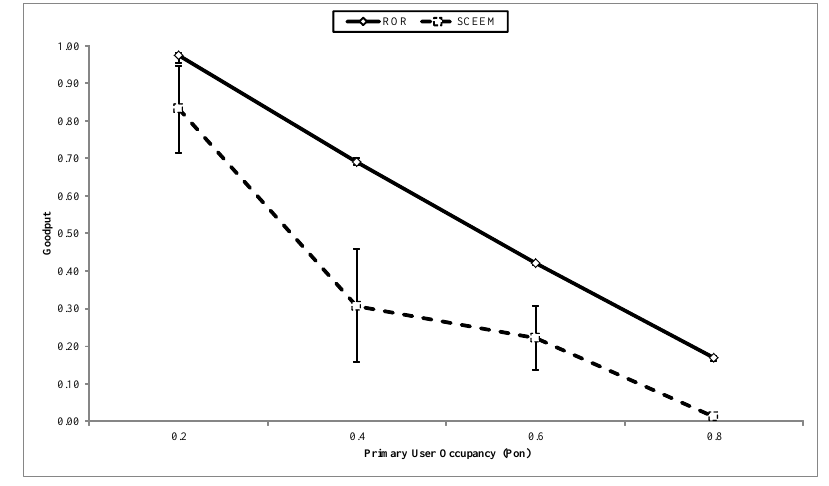
Figure 16. Goodput vs . PU